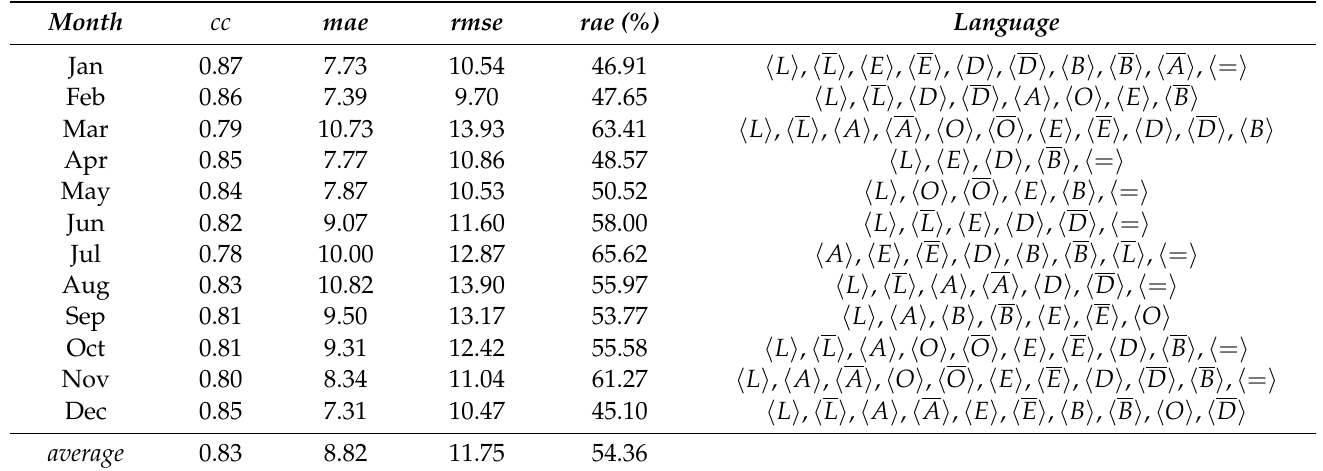
Table 6. Test results, temporal decision tree